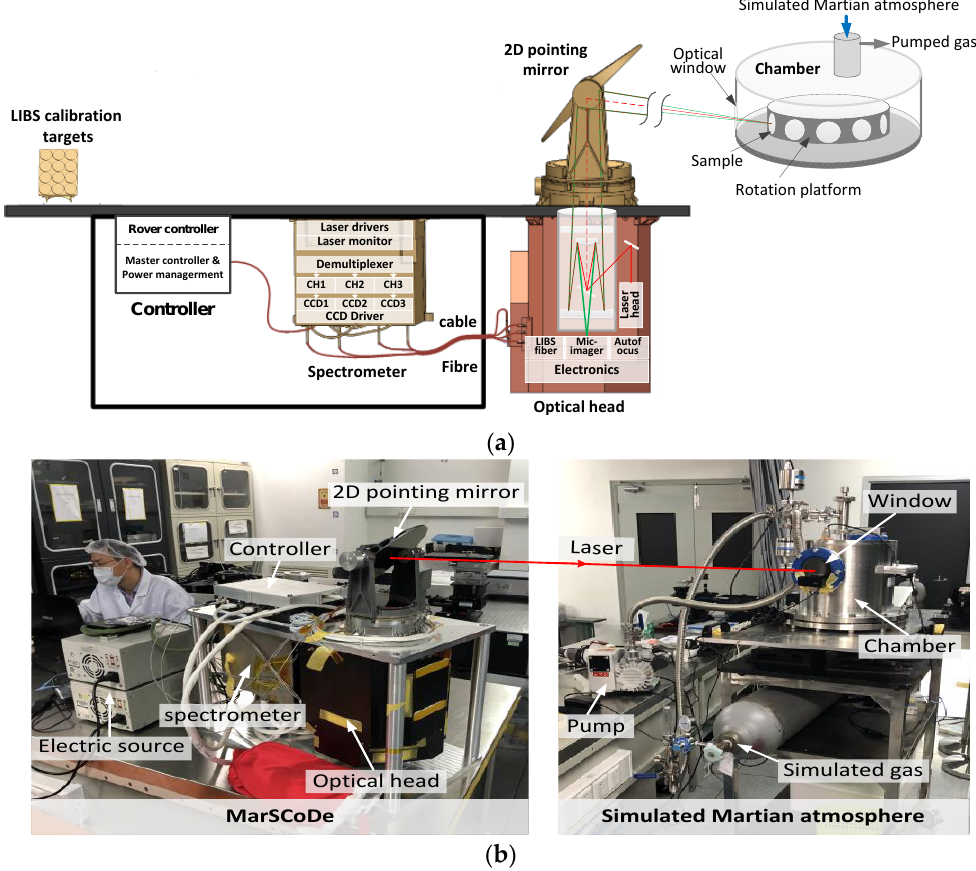
Figure 1. Schematic diagram showing the main units MarSCoDe LIBS and simulated experiment: ( a ) diagram of the instrument and experiment; ( b ) photos of the experimental site. Table 1. Main parameters of MarSCoDe LIBS.